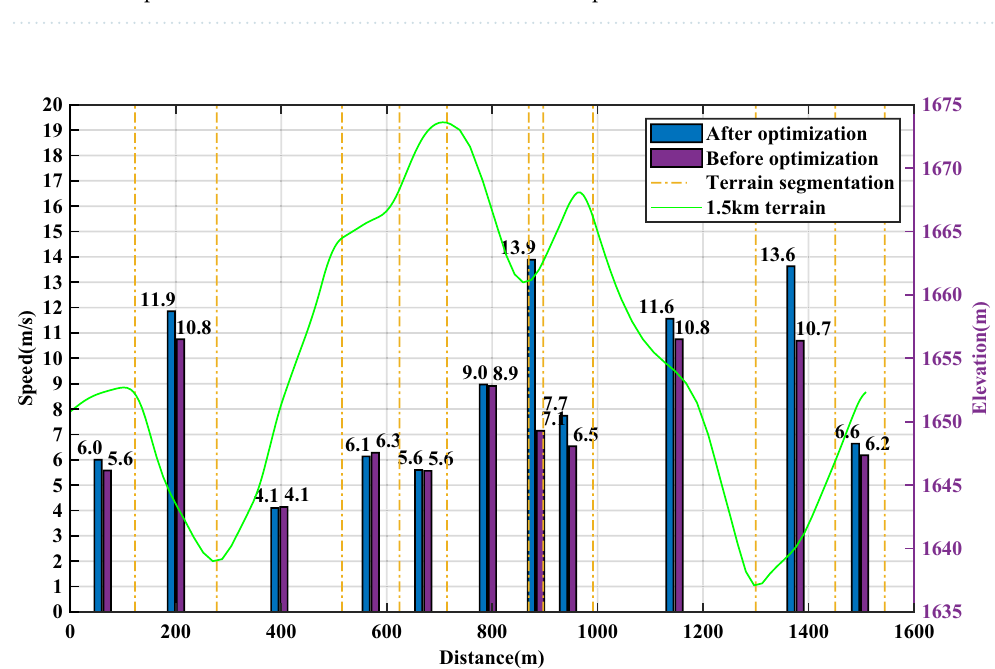
Figure 8. Speed distribution of athlete A before and after optimization.